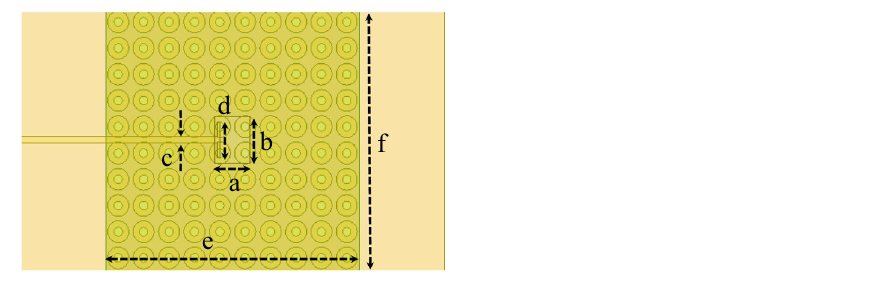
Figure 20. Detailed view of Fig. 19.